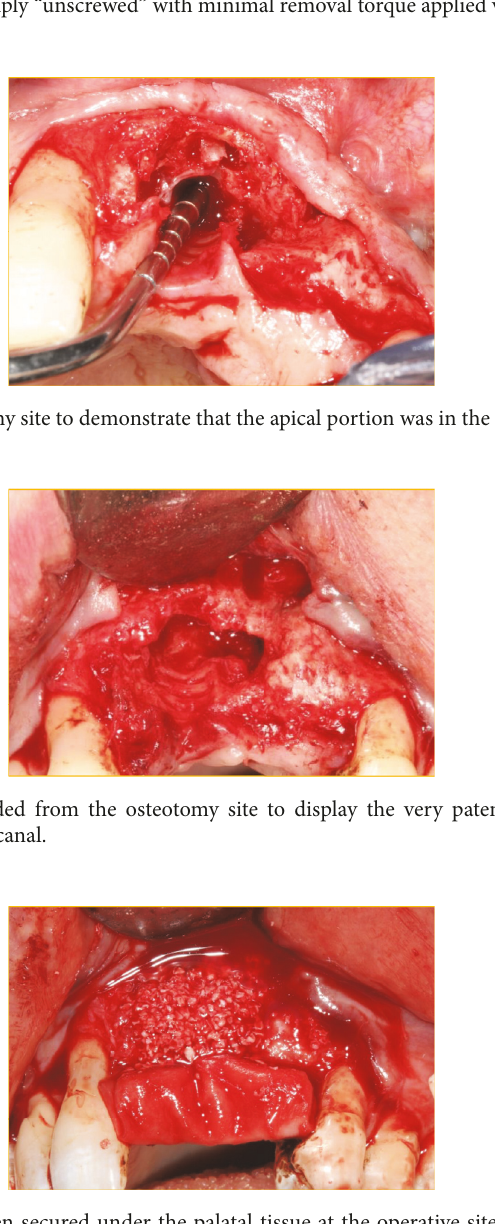
Figure 11: The membrane Bio-Gide has been secured under the palatal tissue at the operative site. Bio-Gide has also been placed at the perforation of the NPD and the distal opening of the conduit inferior to the multiple foramina. The xenograft Bio-Oss has been packed into the “conduit” and then used to augment the deficient buccal bony